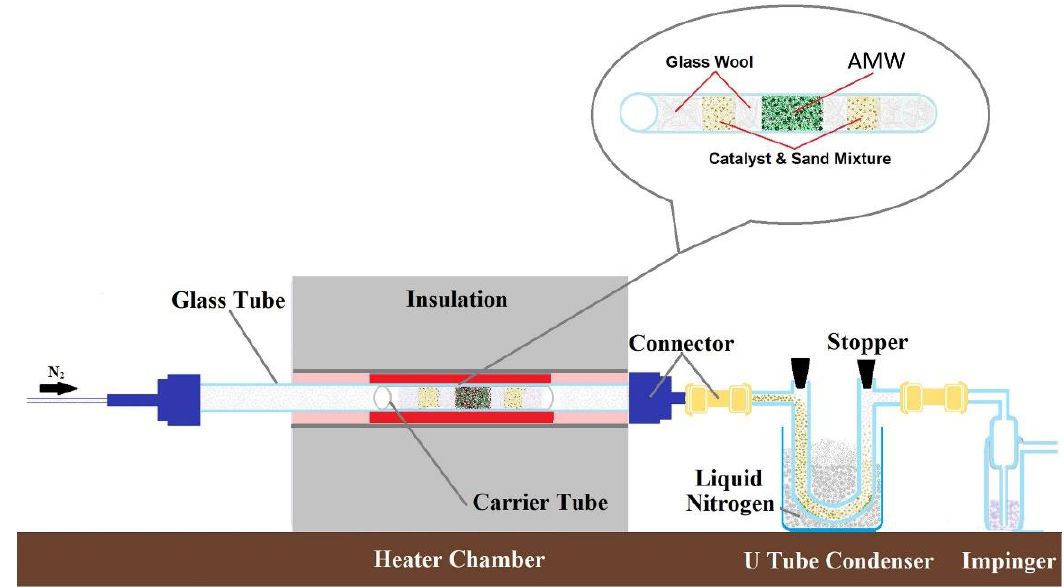
Figure 11. Schematic of the tubular batch reactor .